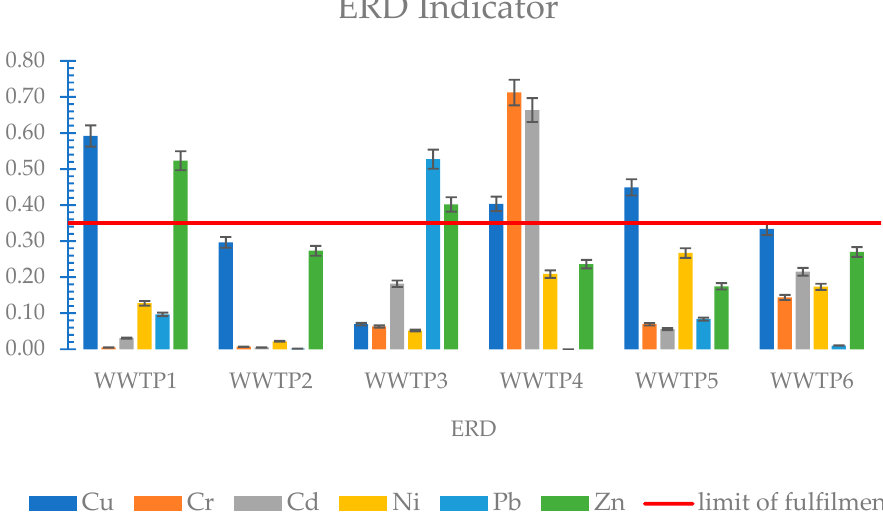
Figure 6. ERD indicator of heavy metals in sewage sludge.